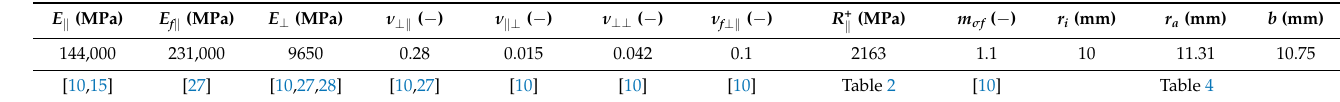
Table 5. CFRP strap’s geometric and material properties considered in the elastic strength prediction after [10,36]. Sources for the data assumed are given in the last row of the